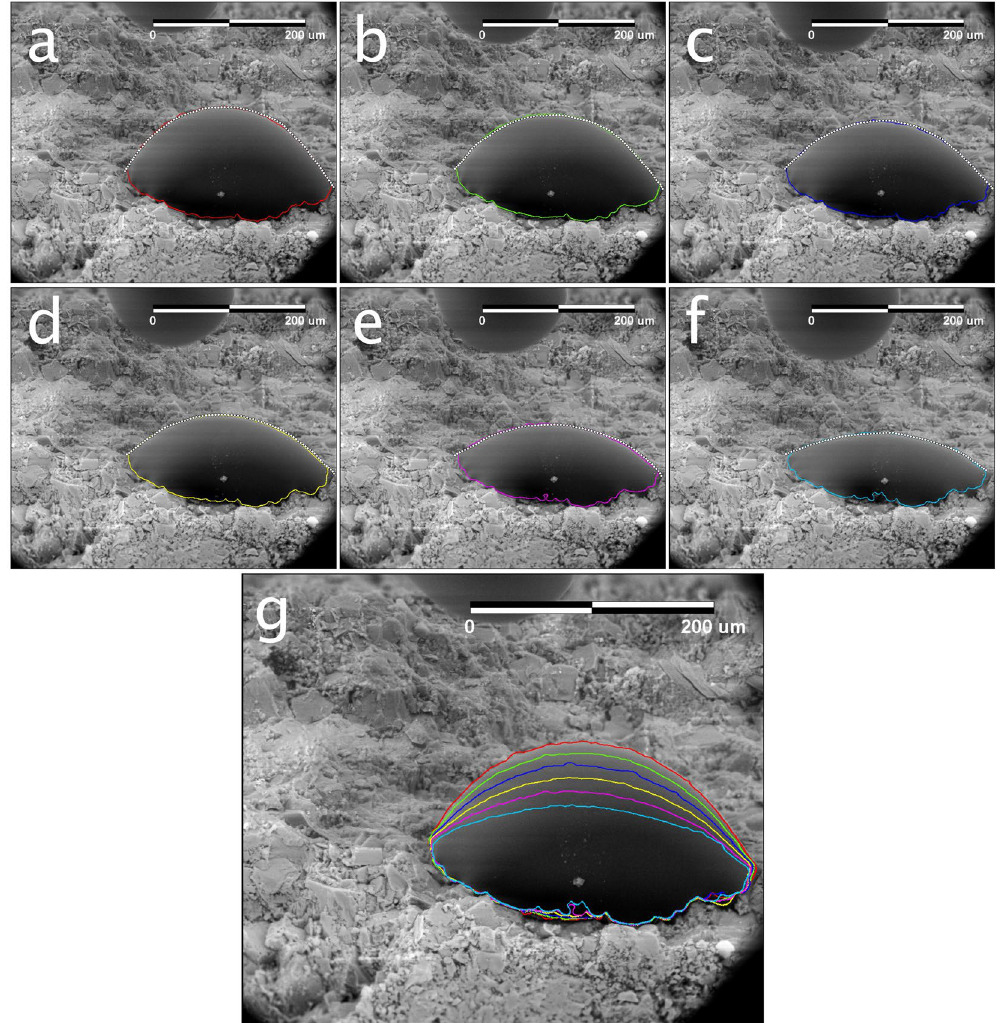
Figure 8. ( a – f ) Time-lapse images (combined secondary and back-scattered electron) of micro-droplet imbibition into Sample 1B. The colored outlines in each frame illustrate the extracted droplet profile, while the white dotted lines represent the fitted, parameterized Young-Laplace Equation to the outer surface of the micro-droplet. The frame time is one second. ( a) Red: the calculated left and right contact angles are 65° and 51°, respectively. ( b ) Green: the calculated left and right contact angles are 56° and 46°, respectively. ( c ) Dark blue: the calculated left and right contact angles are 51° and 38°, respectively. ( d ) Yellow: the calculated left and right contact angles are 40° and 30°, respectively. ( e ) Purple: the calculated left and right contact angles are 32° and 26°, respectively. ( f ) Light blue: the calculated left and right contact angles are 23° and 21°, respectively. ( g ) Summary image illustrating micro-droplet profile changes during imbibition. The scale bars are 200 µ